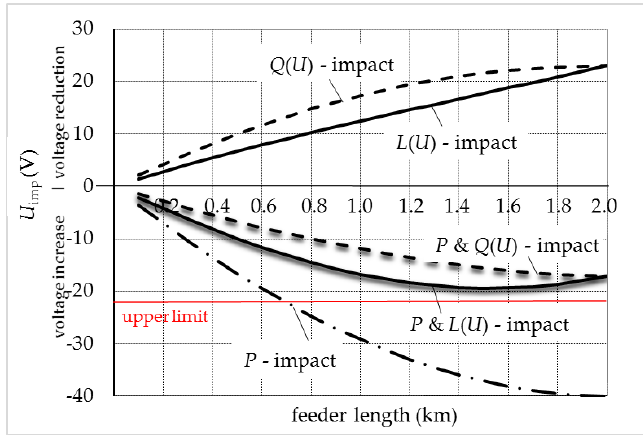
Figure 13. Voltage profiles for different control strategies: No control (inverters inject with cos(  ) = 1), distributed Q ( U ) and concentrated L ( U ) control.